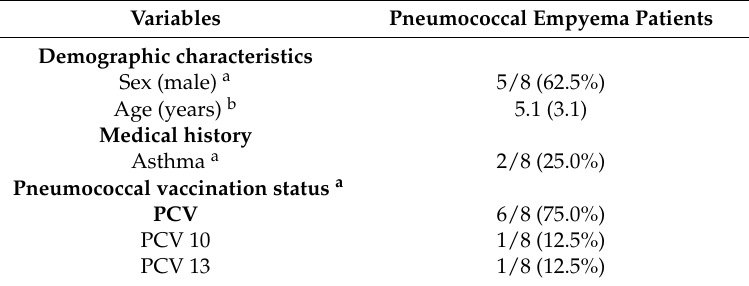
Table 1. Summary of demographic and clinical characteristics of the study